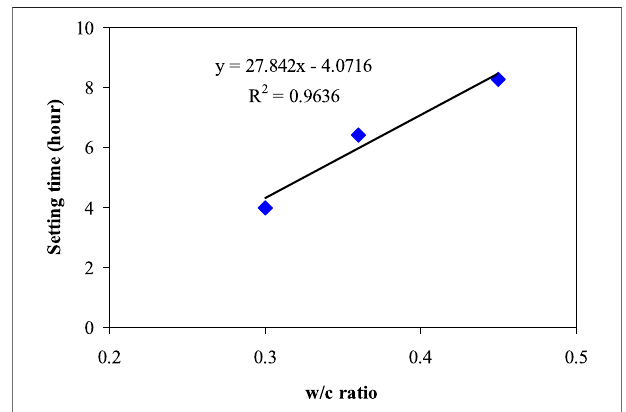
FIGURE 7 | Setting time versus the w/c ratio of the cement paste (after Amziane (Mindess and Young, 1981)).